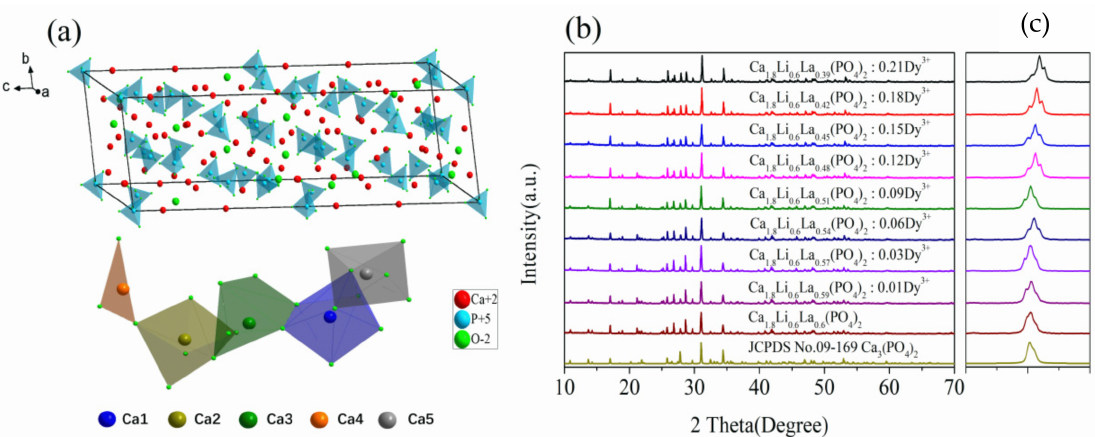
Figure 1. ( a ) Cell structure diagram of β -Ca 3 (PO 4 ) 2 , ( b , c ) XRD patterns of Ca 1.8 Li 0.6 La 0.6 − x (PO 4 ) 2 :xDy 3+ phosphor and JCPDS